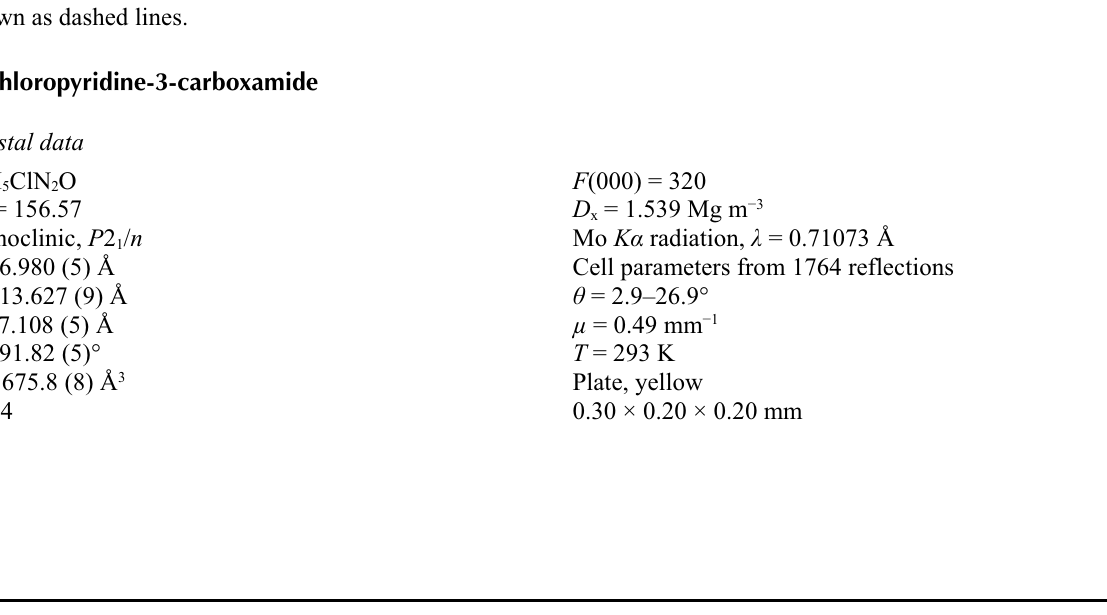
Crystal structure of the title compound along [100] with intermolecular N—H···N and N—H···O hydrogen bonding shown as dashed